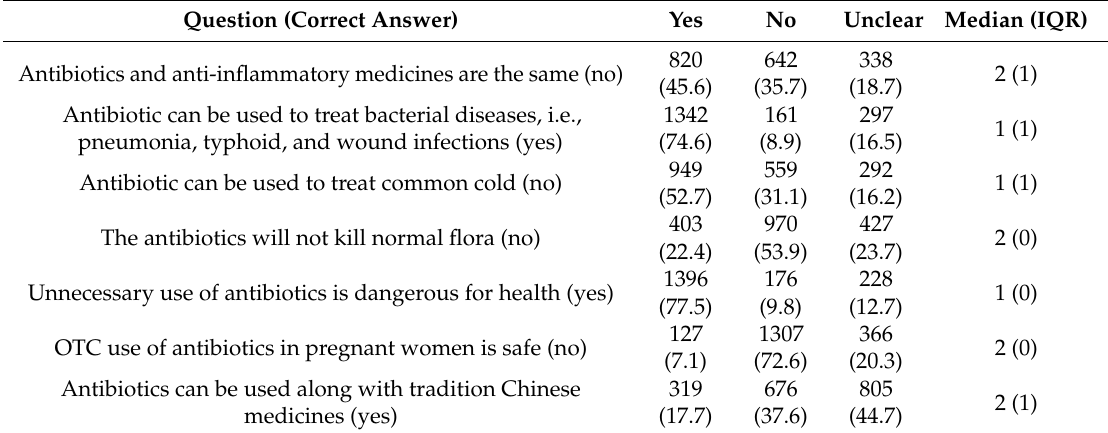
Table 2. Knowledge of participants about antibiotics ( n =